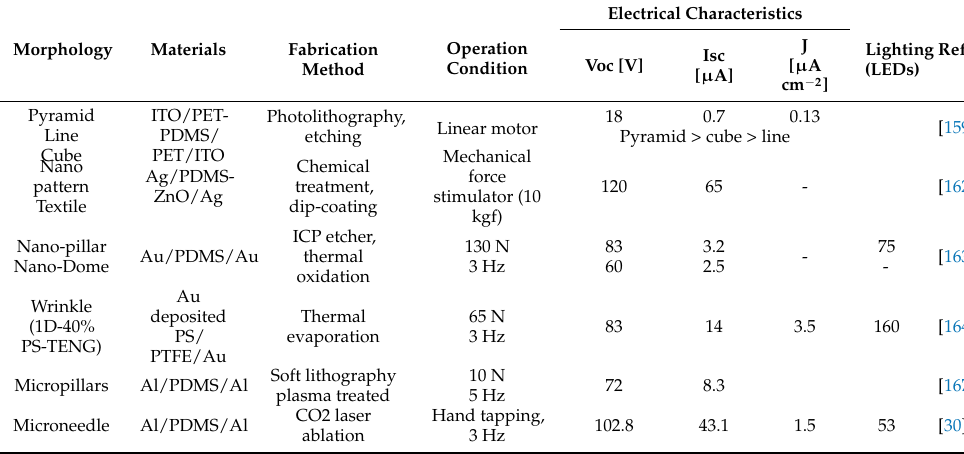
Table 2. Comparison of surface morphology, materials, fabrication methods, operation condition, and electrical characteristics.